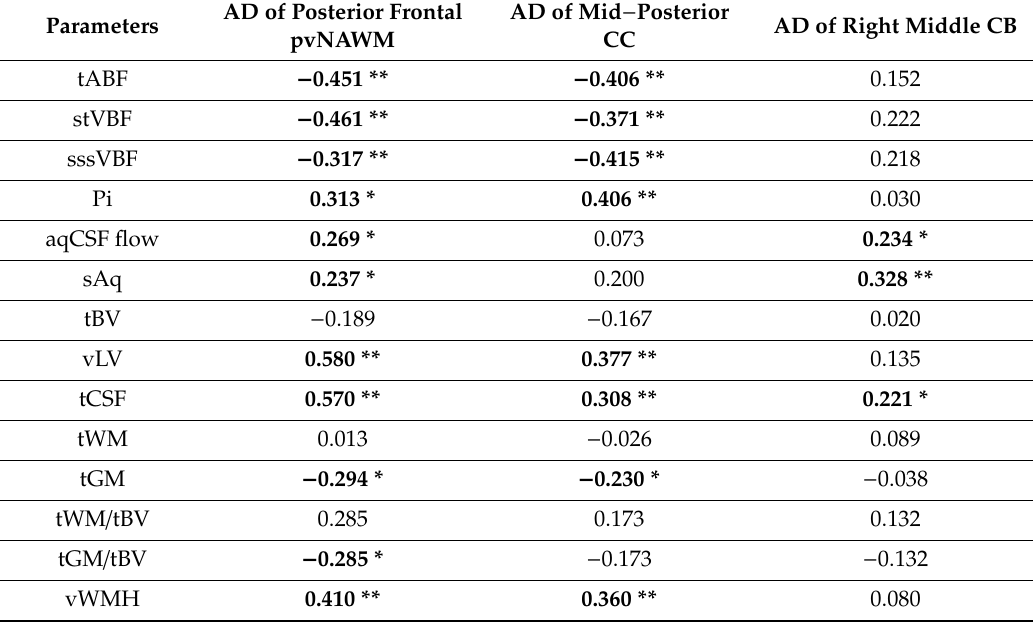
Table 6. Relationships between the di ff usion tensor imaging (DTI) predictors of CI and the phase contrast MRI (PC–MRI) and morphometry